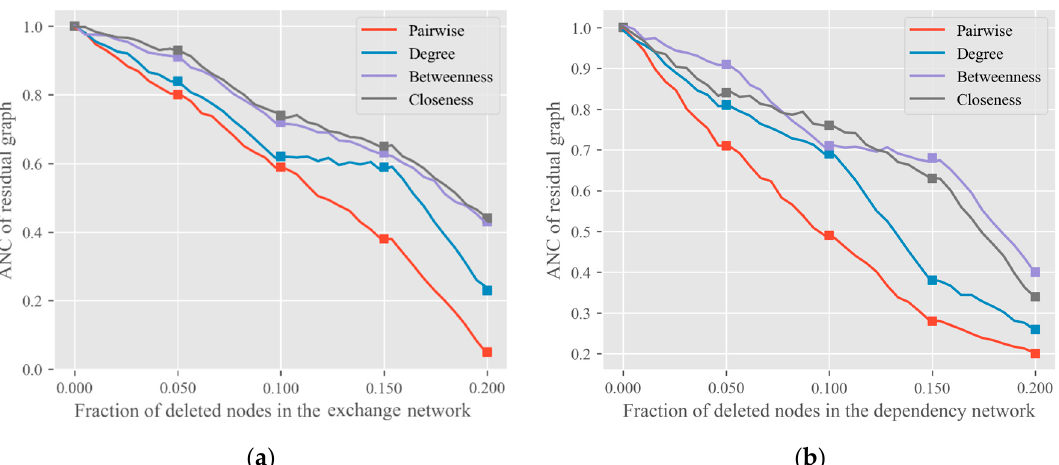
Figure 5. The ANC results of DMGCN on ( a ) the exchange network, and ( b ) the dependency network, specified by the pairwise connectivity, degree, betweenness, and closeness centralities.